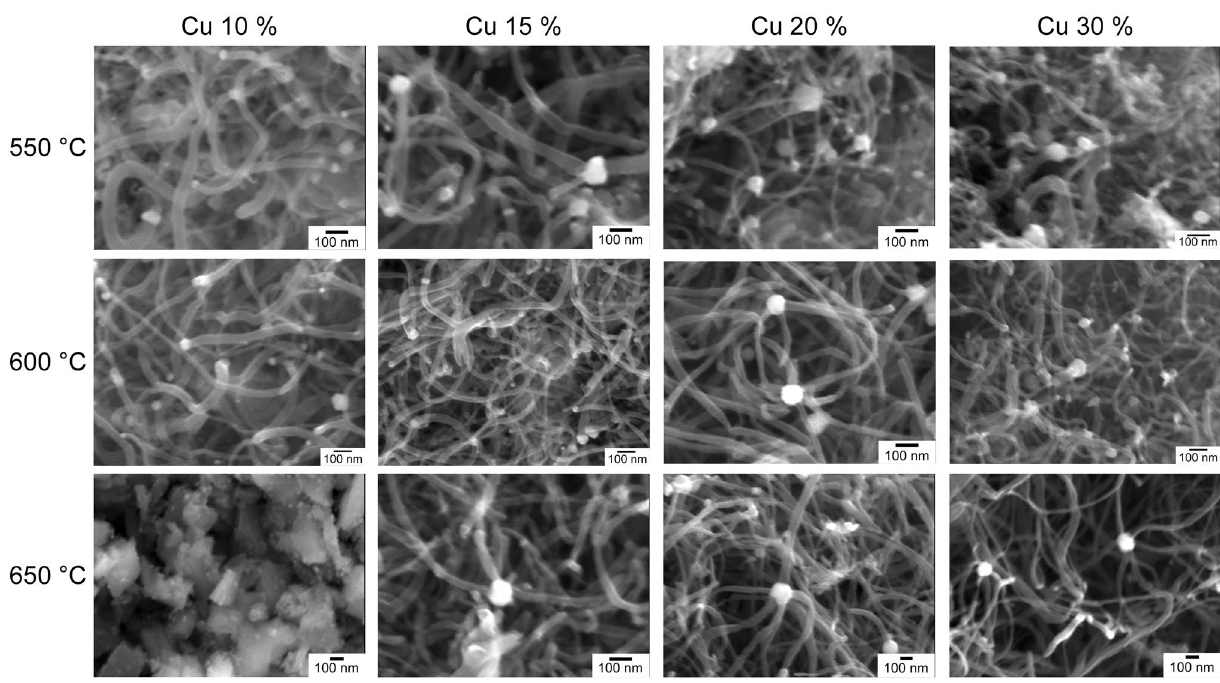
Fig. 4 SEM images of the Marimo-like carbon grown with Ni-Cu bimetal